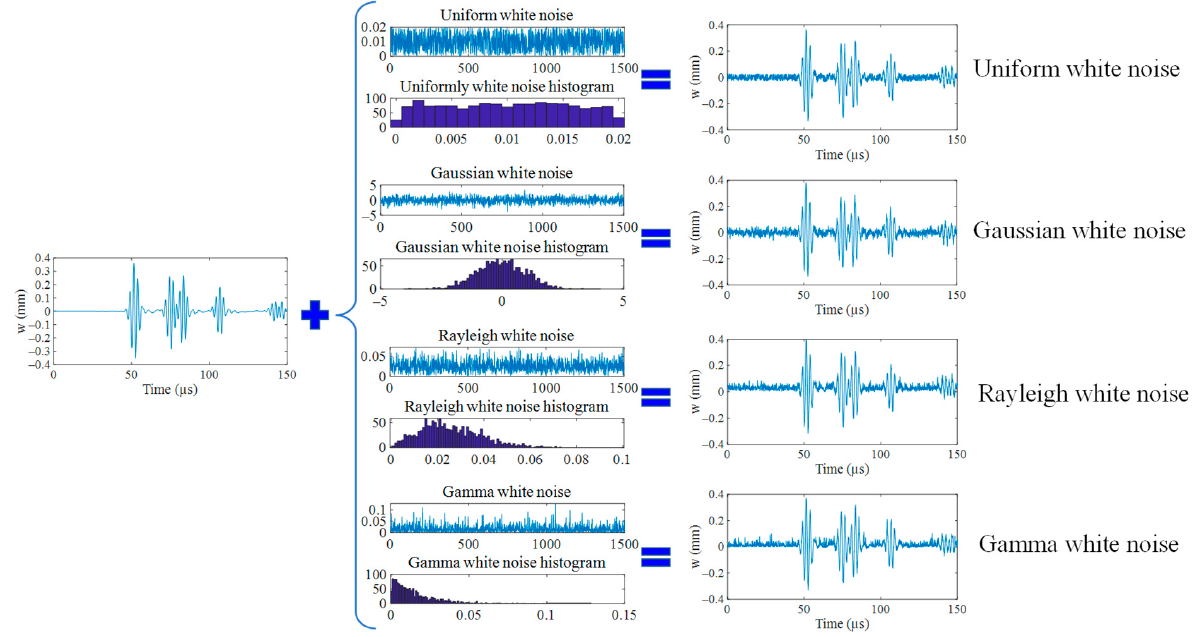
Figure 3. Adding four different groups of noise for data enhancement.